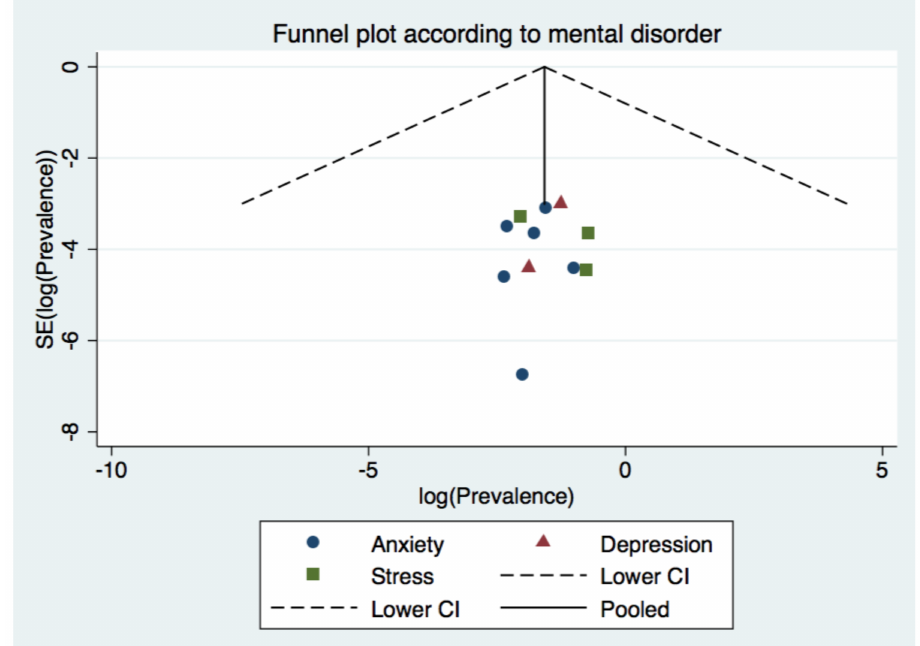
Figure 3. Funnel plot for the prevalence of mental